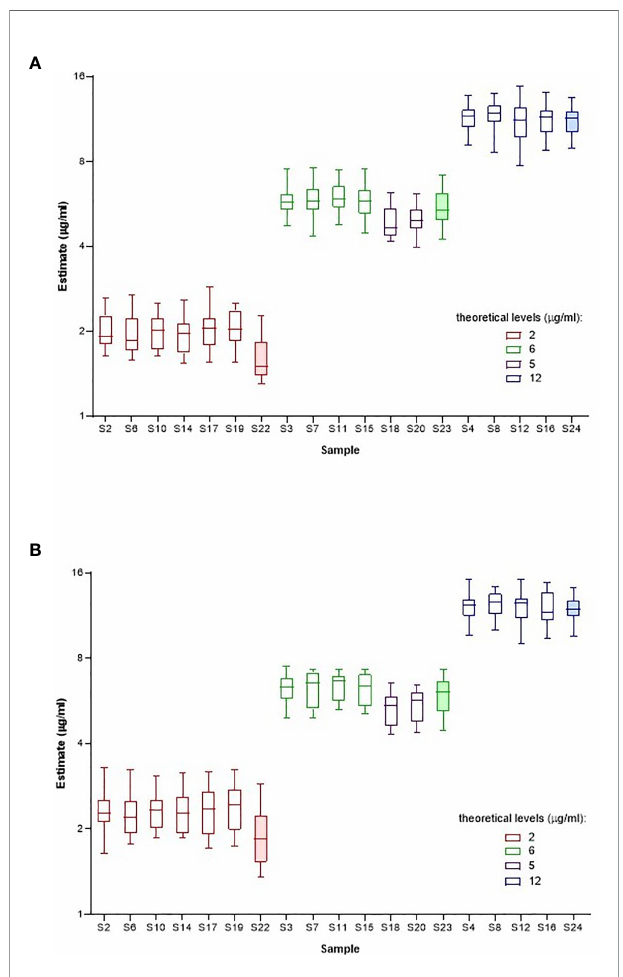
FIGURE 2 | Laboratory geometric mean content estimates (µg/ml) for spiked samples S1-S24 calculated relative to kit or in-house standards (A) and Sample A (B) . Boxes represent the interquartile range and the line shows the median. The bars represent the range from the maximum to minimum